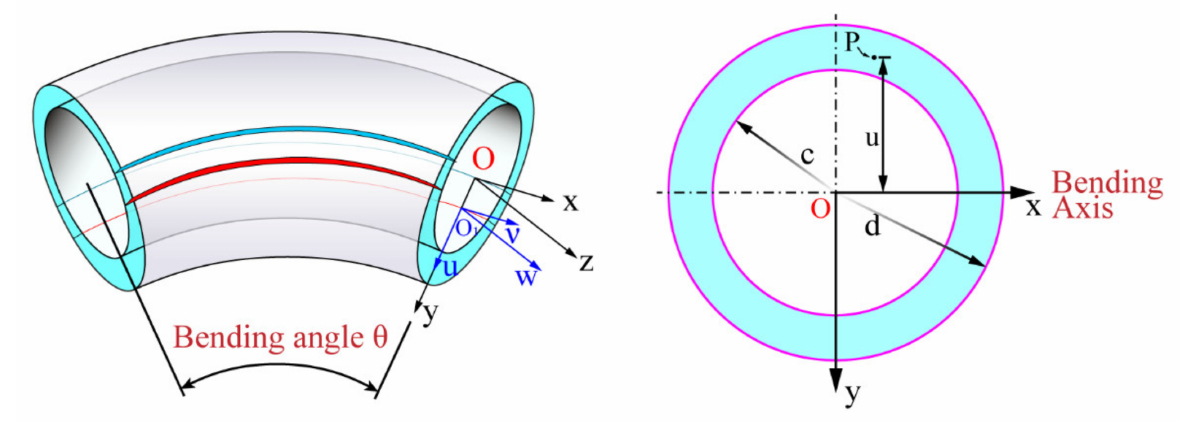
Figure 1. Schematic diagram of cross-sectional shape and pure bending forming of the